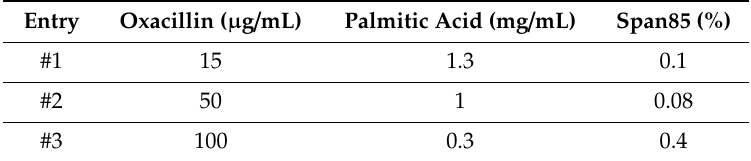
Table 4. Optimized sets of variables using response